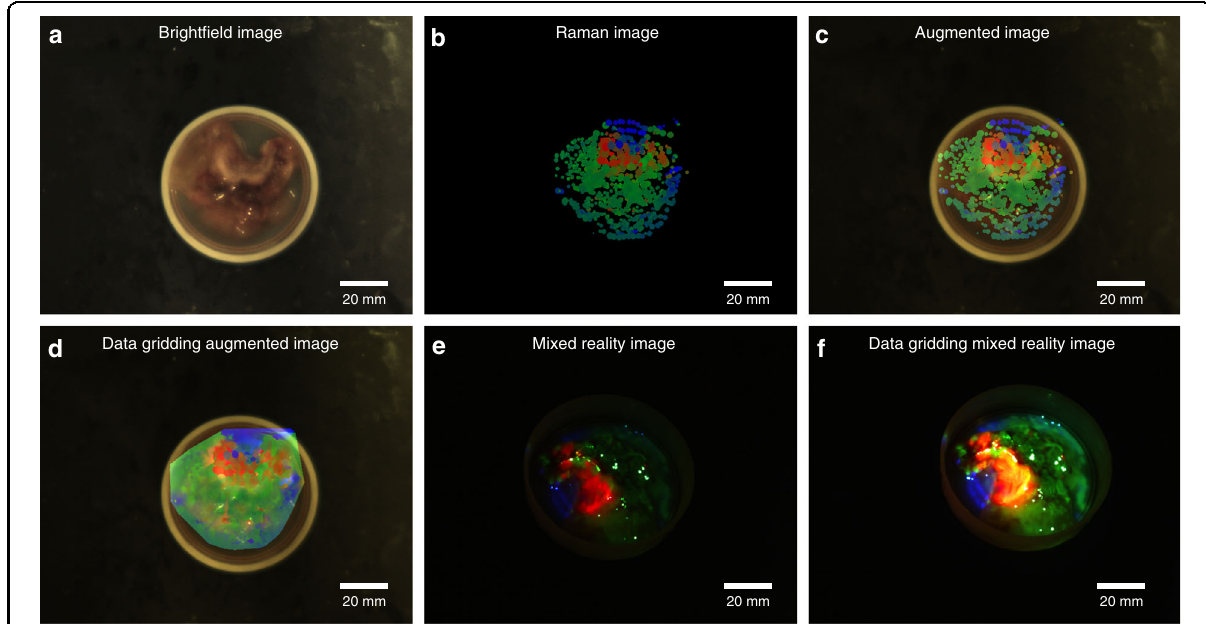
Fig. 2 Representative results of the proposed approach on the ex-vivo clinical sample. a Bright fi eld image of the sample does not allow to differentiate between different molecular regions. b Raman imaging with the presented approach readily enables the visualization of distinct molecular locations. c The augmentation of the molecular information with the bright fi eld image provides distinct differentiation of the information of the sample. d Data gridding of molecular information and augmented overlay with bright fi eld image. e Mixed Raman reality image enabled through projection the direct visualization of the molecular information in the sample plane; and, in combination with data gridding ( f ), provides a rich image with molecular distinct boundaries. The color information represents the different chemical components, i.e., red for collagen, green for epithelial tissue, and blue for the plastic sample